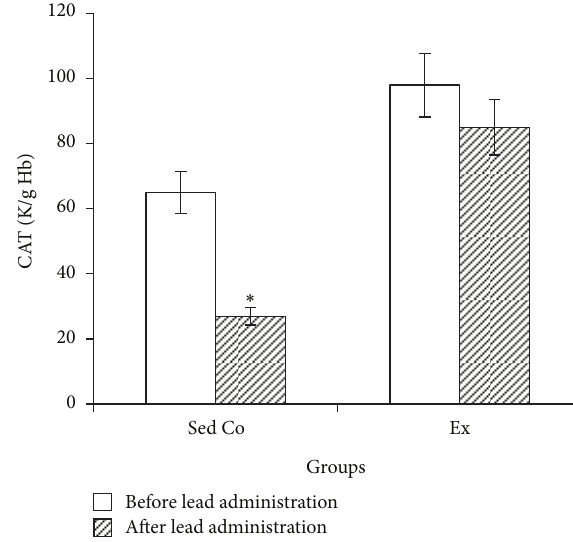
Figure 1: Blood superoxide dismutase in sedentary control and exercise groups before and after lead administrations. Seven days of lead injections (15mg/Kg body weight, ip) to sedentary animals housed in the regular cages caused significant reduction of blood SOD ( ∗ 𝑃 < 0.05 compared to the “before lead administration”); in Ex animals housed in the wheel equipped cages, SOD changes after the same dose lead administration were not significant. The data are presented as means ± S.E.M. SOD: superoxide dismutase; Sed Co: sedentary control group; Ex: exercise group.